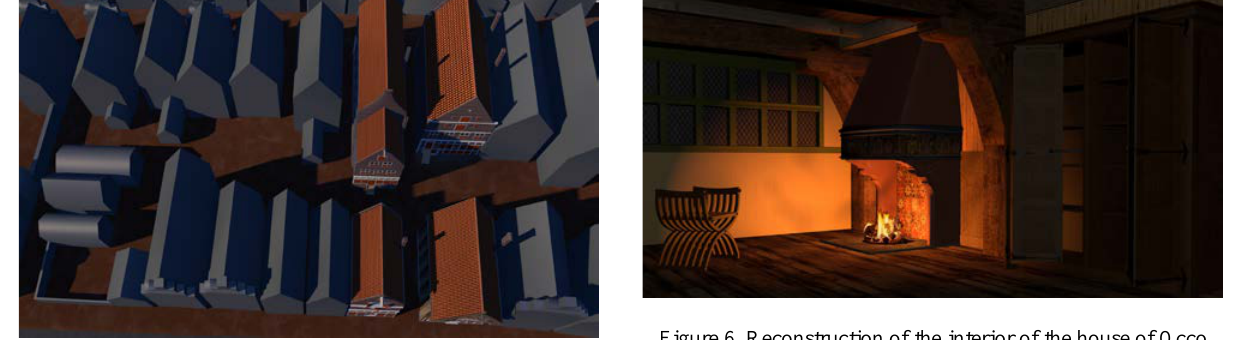
Figure 5. Reconstruction of the alley (image L. Opgenhaffen)